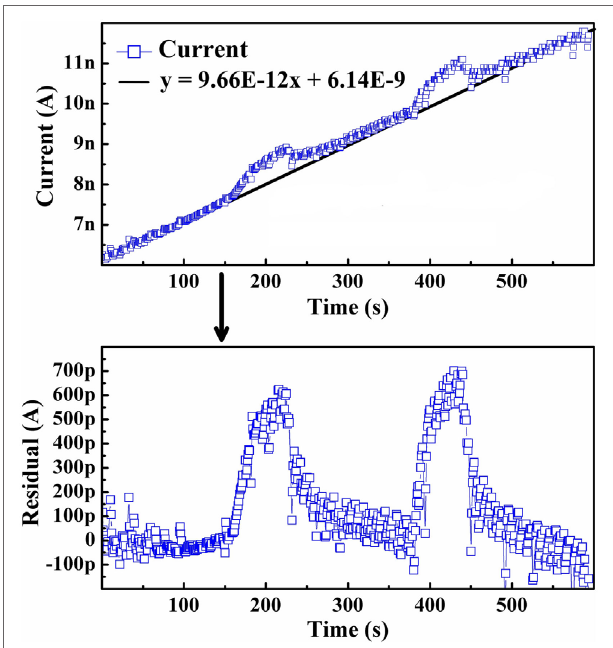
FigUre 3 | Example of the residual plot performed for all isothermal tests. This technique was utilized to determine the magnitude of current increase due to the introduction of